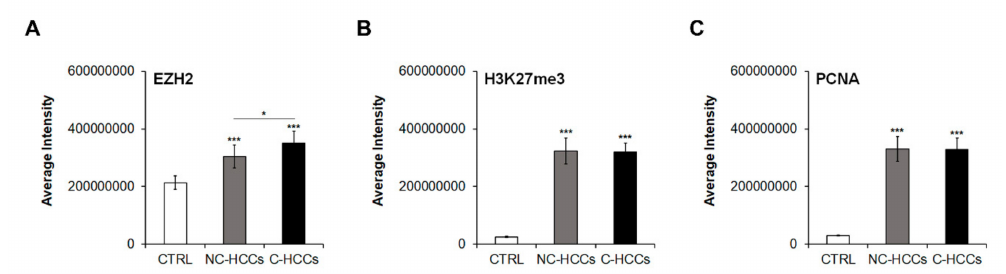
Figure 4. Quantitative imaging of EZH2, H3K27me3, and PCNA in pediatric HCCs. Average fluorescence intensity calculated for ( A ) EZH2, ( B ) H3K27me3, and ( C ) PCNA in CTRL and in pediatric HCCs according to cirrhotic / non-cirrhotic milieu (*, p < 0.05; ***, p < 0.001 vs. CTRL).